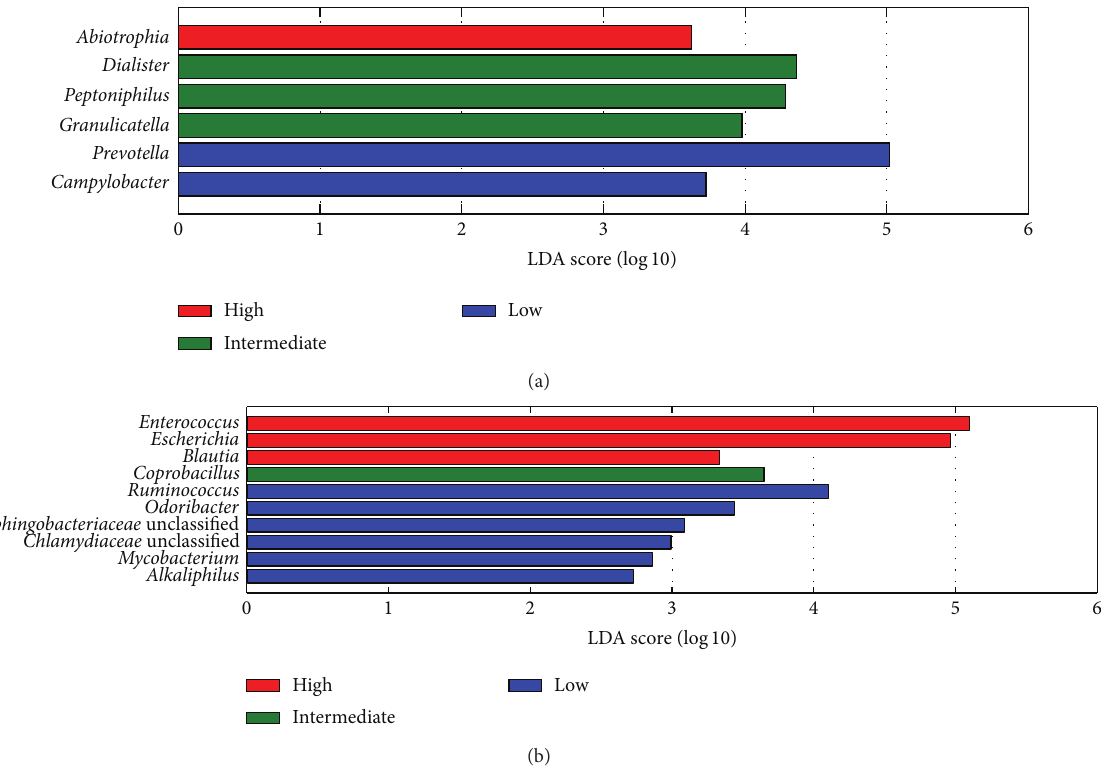
Figure 3: Bacterial genera that discriminate between low ( < 30%, shown in blue), intermediate (30–70%, shown in green), and high ( > 70%, shown in red) proportions of human DNA in (a) CDI cases and (b) hospitalized controls. The histograms show bacterial genera with an absolute log linear discriminant analysis (LDA) score of at least